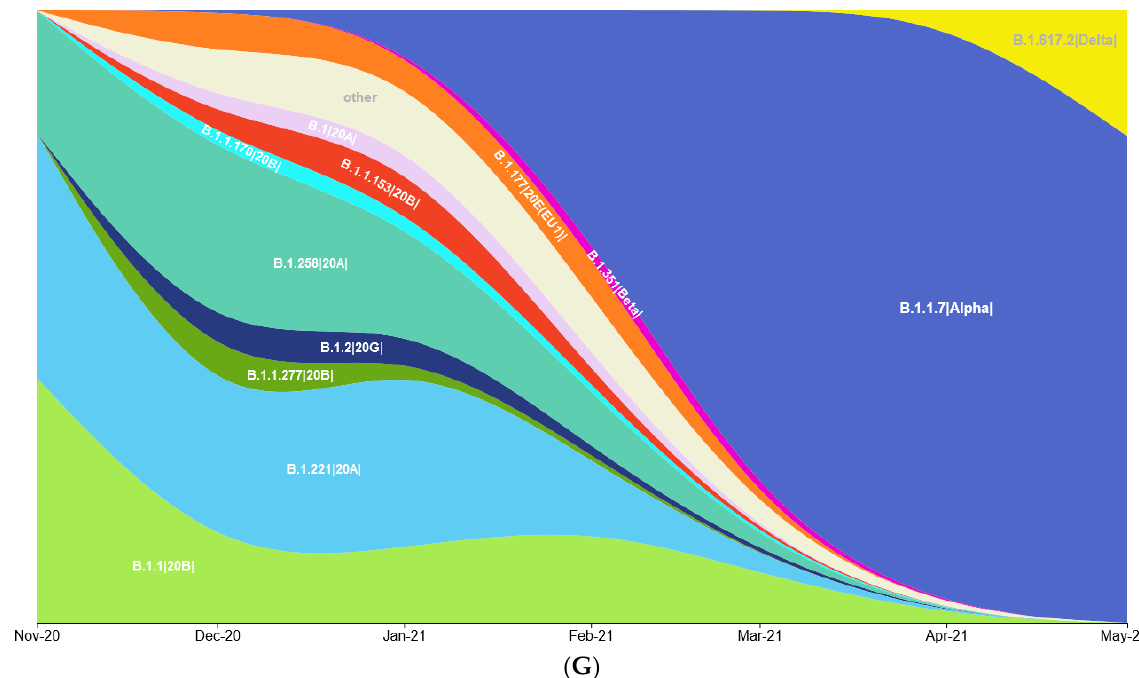
Figure 1. Lineage size breakdown of genomes collected monthly in each of seven investigated re- gions. Distribution of: ( A ) 14 major SARS-CoV-2 lineages circulating between March 2020 and May 2021 in Berlin state; ( B ) 10 major SARS-CoV-2 lineages circulating between December 2020 and May 2021 in Brandenburg; ( C ) seven major SARS-CoV-2 lineages circulating between January and May 2021 in Mecklenburg — West-Pomerania; ( D ) eight major SARS-CoV-2 lineages circulating between